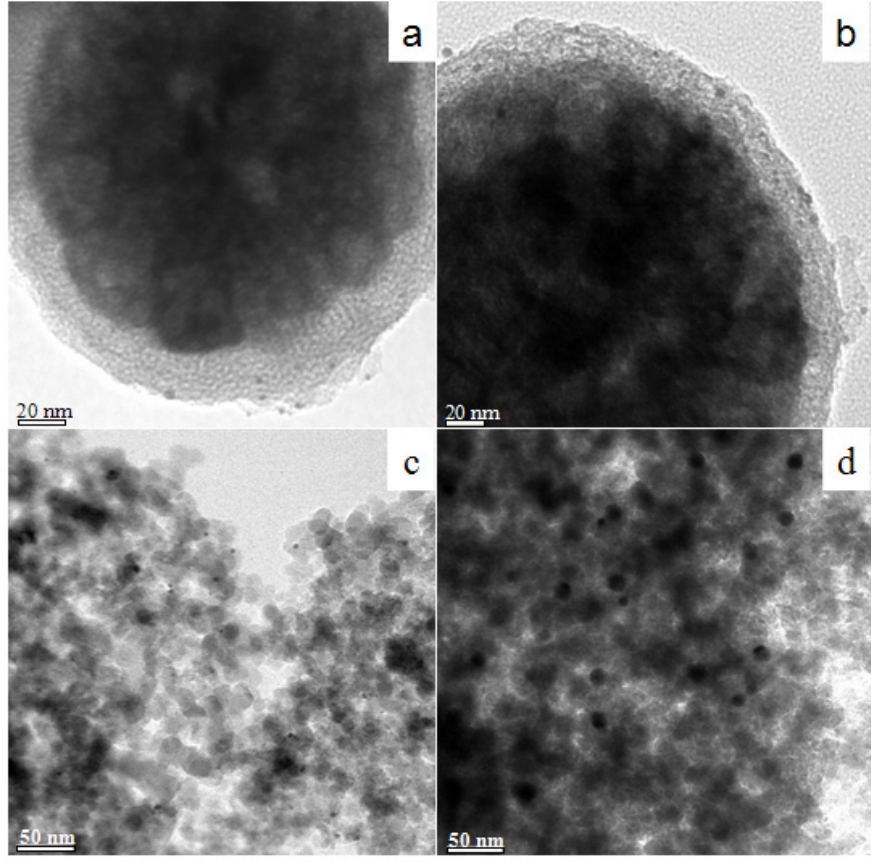
/Fe O ( a ), Au/m-SiO 2 3 4 calcined at 500 °C ( d ). 2